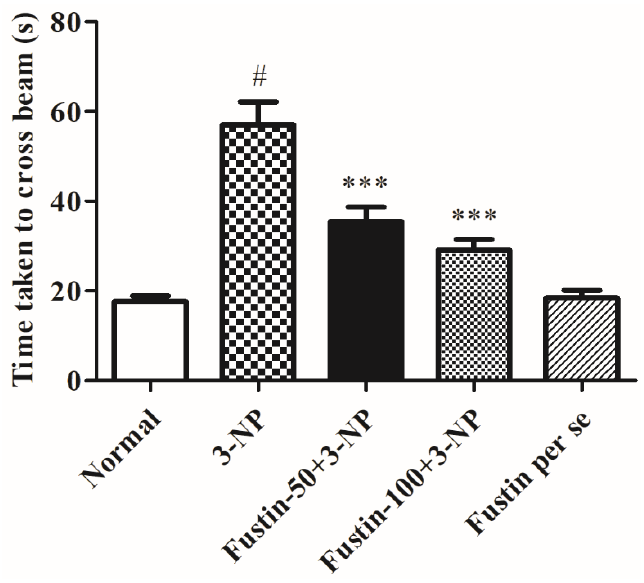
Figure 2. Effect of fustin on beam walk test against 3-nitropropionic acid-induced Huntington’s-like effects in rats. Values are expressed as mean ± S.E.M. ( n = 6). Values are statistically significant at # p < 0.05 vs. negative control group, *** p < 0.001 vs. 3-nitropropionic acid, respectively (One-way ANOVA followed by Tukey’s test).